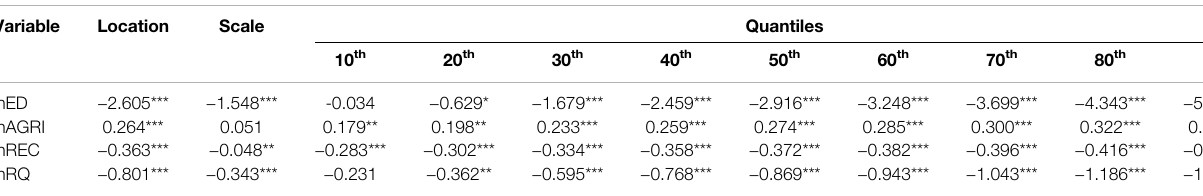
TABLE 6 | Panel quantile estimation-MMQR.